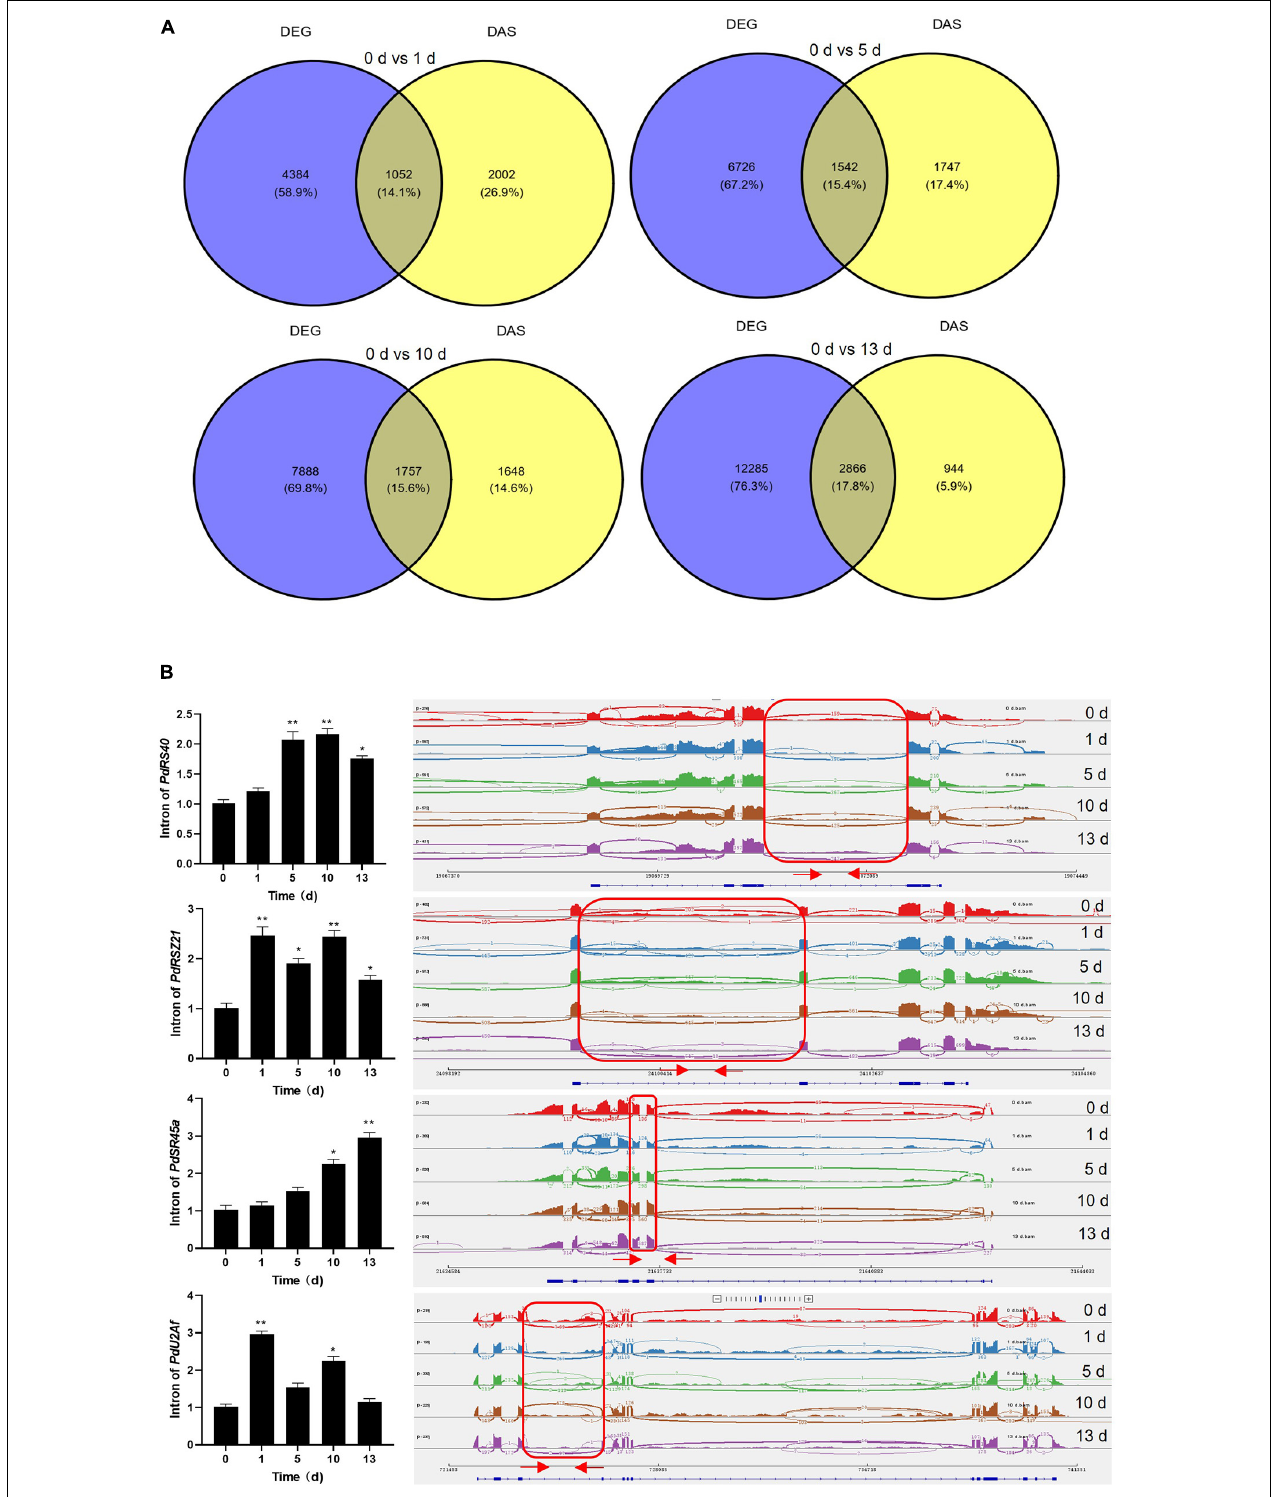
FIGURE 6 | Categorization of DEGs and DAS events and validation of DAS events. (A) Venn diagram of the overlap of DEGs and DAS events. (B) Validation of DAS events which were related to splicing factors by quantitative real-time-PCR (qRT-PCR). qRT-PCR analysis was performed for four splicing factors in date palm for indicated time under salt stress condition (1 M NaCl). The expression of PdUbiquitin was used as the internal control. Red arrows in the right panel showed the primers position of each intron. Error bar means ± SD ( n = 3). Asterisks indicate significant differences (* p < 0.05 and ** p < 0.01).